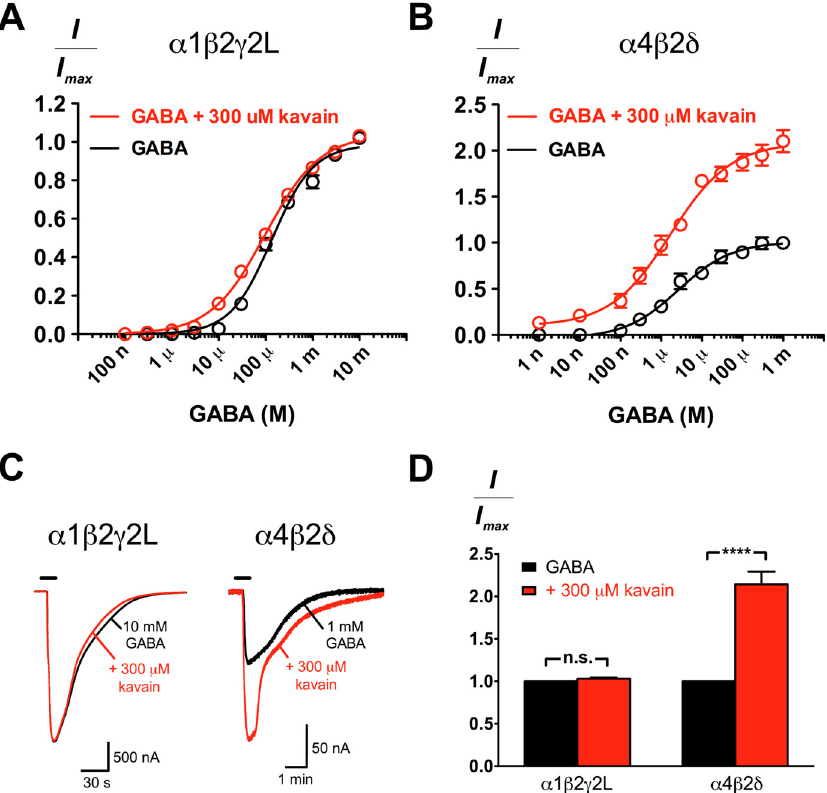
Fig 3. Kavain produced greater enhancement of GABA-elicited currents at α 4 β 2 δ than at α 1 β 2 γ 2L GABA A Rs. (A) GABA concentration-response curves in the absence (black; n = 10) and presence (red; n = 6) of 300 μ M kavain at α 1 β 2 γ 2L GABA A Rs. The curve parameters are summarised in Table 1. (B) GABA concentration-response curves in the absence (black; n = 4) and presence (red; n = 4) of 300 μ M kavain at α 4 β 2 δ GABA A Rs. The curve parameters are summarised in Table 1. (C) Superimposed current responses of maximal GABA in the absence (black) and presence (red) of 300 μ M kavain at α 1 β 2 γ 2L and α 4 β 2 δ GABA A Rs. (D) The effect of kavain on the maximal GABA current responses at α 1 β 2 γ 2L ( n = 6) and α 4 β 2 δ ( n = 7) GABA A Rs was compared using the paired t test, and the significance levels are indicated with n.s. (not significant) and **** ( p < 0.0001). Data are presented as mean ±